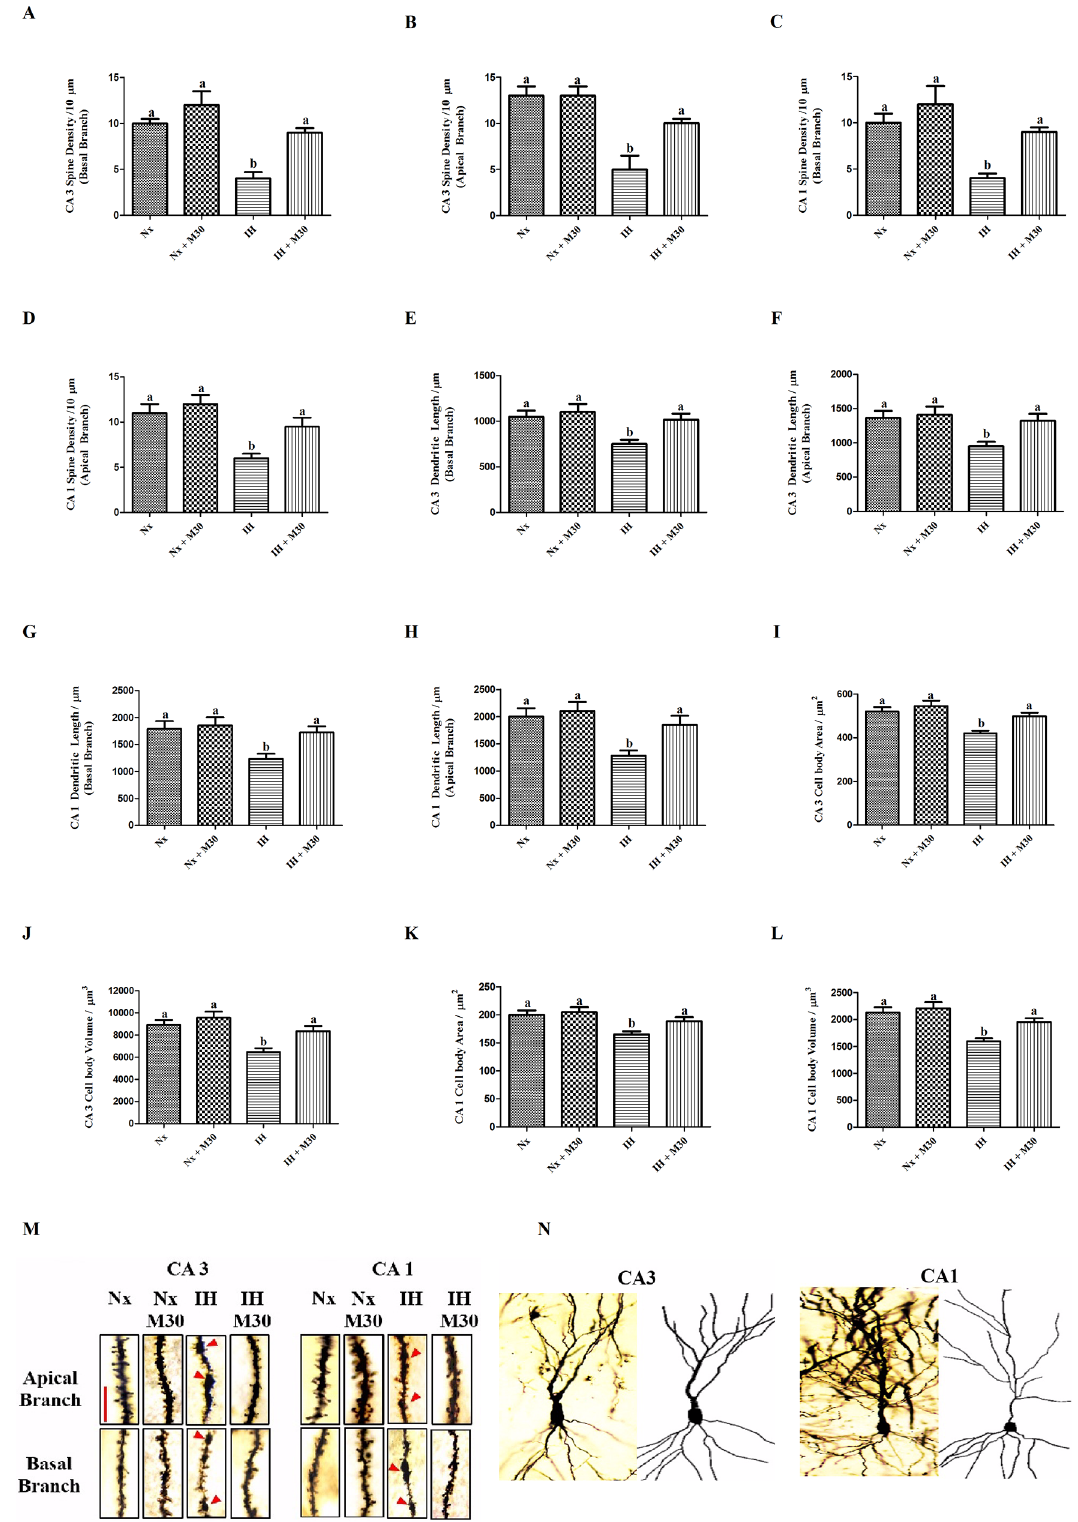
Fig 3. Hypoxia induced decreasesin dendritic spine density, length, soma size and volume of the apical and basal branches of CA1 and CA3 pyramidal neurons. Levels of the dendriticspine densitiesof (A) CA3 basal branch, (B) CA3